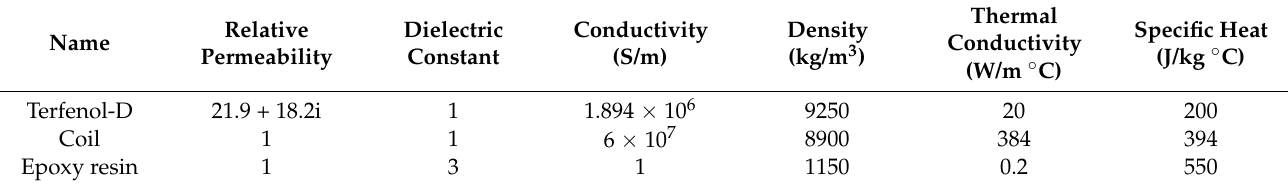
Table 1. Material parameters of rod vibrator.